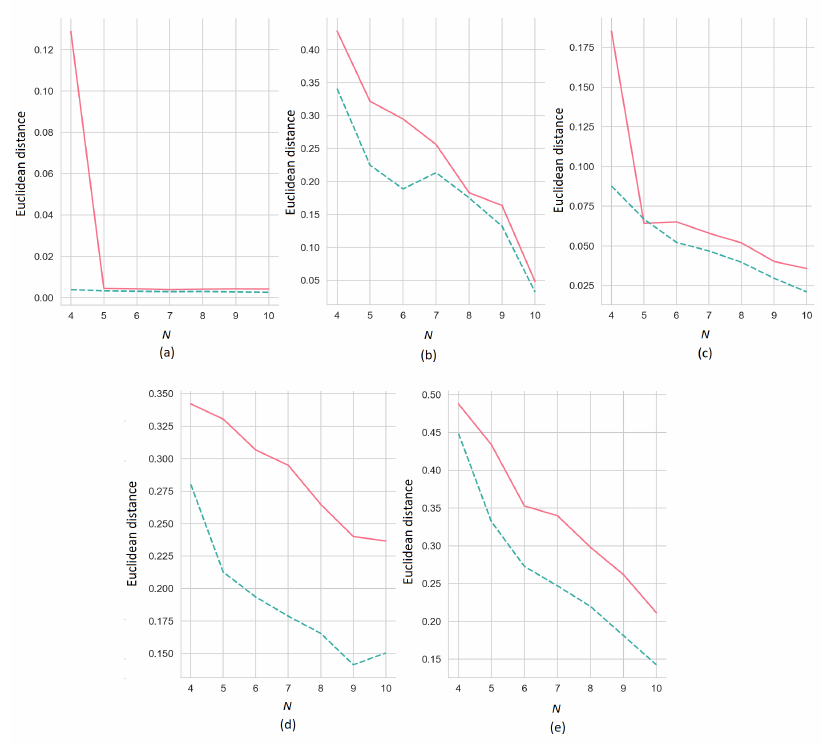
Figure 6. Euclidean distances between ER-SHAP and SHAP as functions of the number of iterations N for t = 2 (the solid line) and 3 (the dashed line) for trained SVMs and five datasets depicted in corresponding Figure 4a–e.